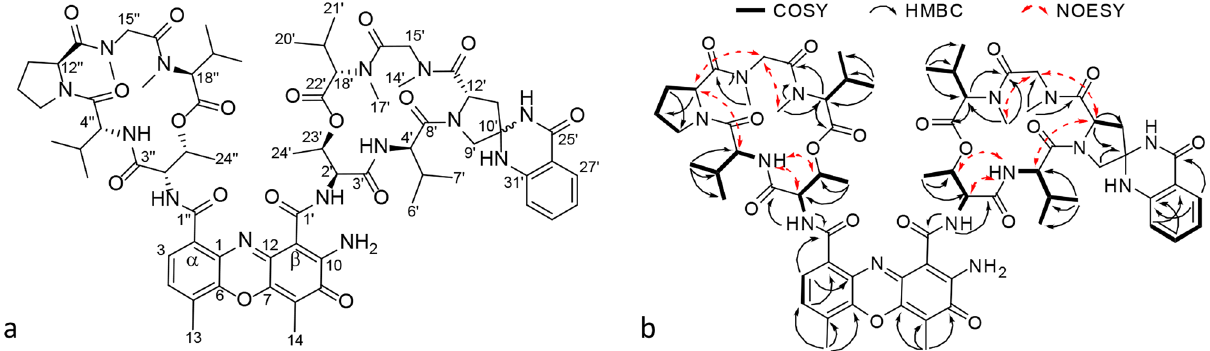
Figure 3. Chemical structures of the new actinomycins. Shown are actinomycin L 1 (10 ′ S ) ( 1 ) and L 2 (10 ′ R ) ( 2 ) ( a ) and the key COSY, HMBC and NOESY correlations for 1 ( b Large scale fermentation and NMR.